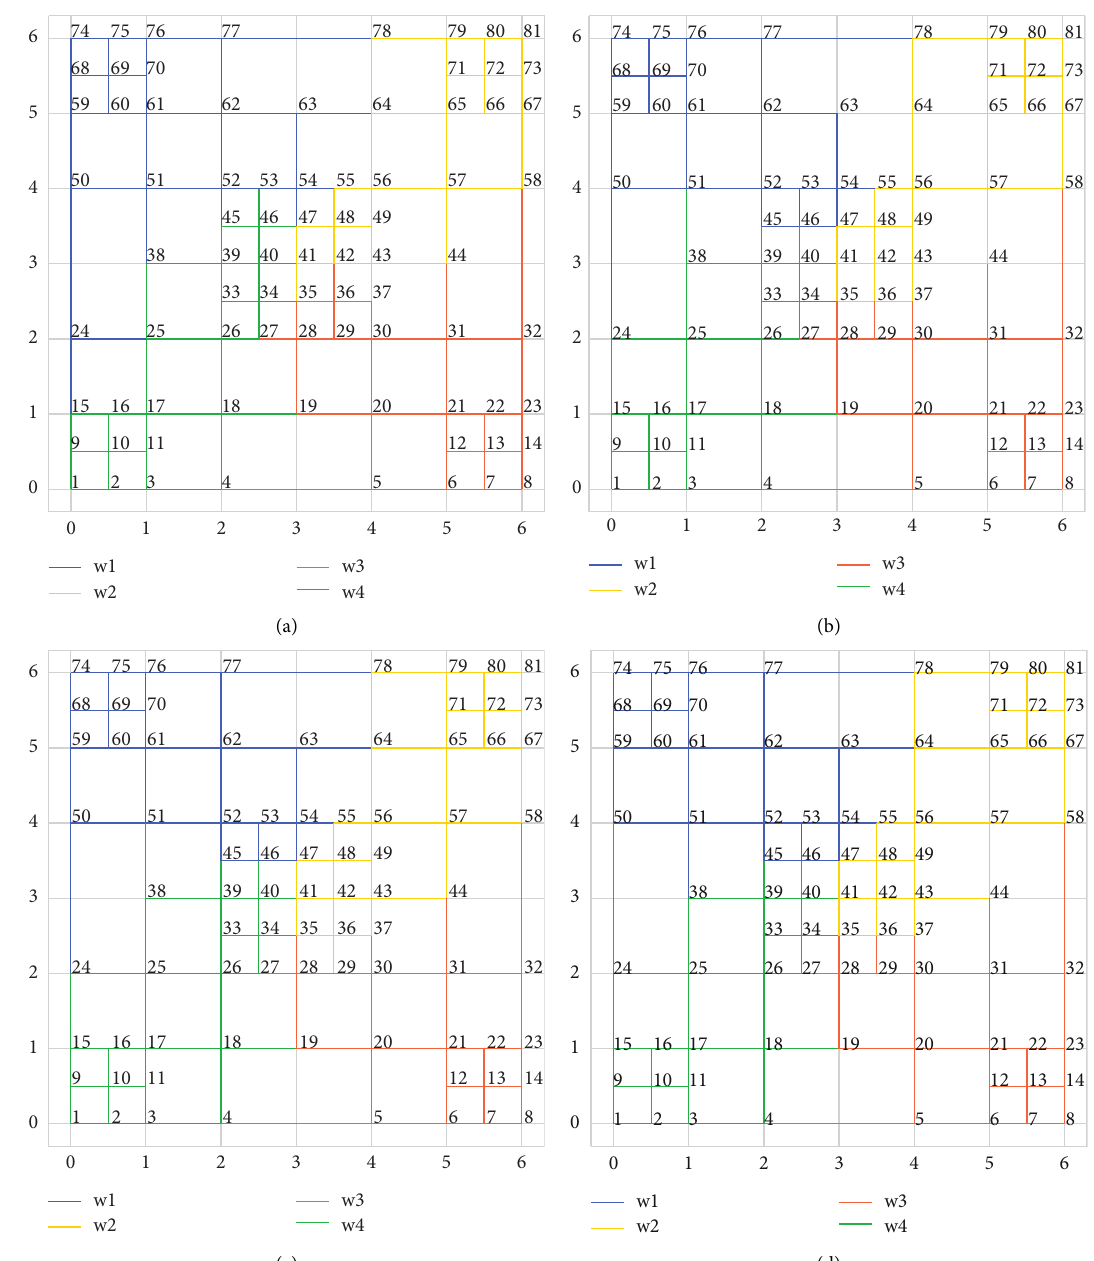
Figure 12: An example of the road network partition result. The blue, yellow, red, and green arcs denote the subzone of workers w , respectively. (a) 8 am. (b) 12 am. (c) 6 pm. (d) 10 and w 4